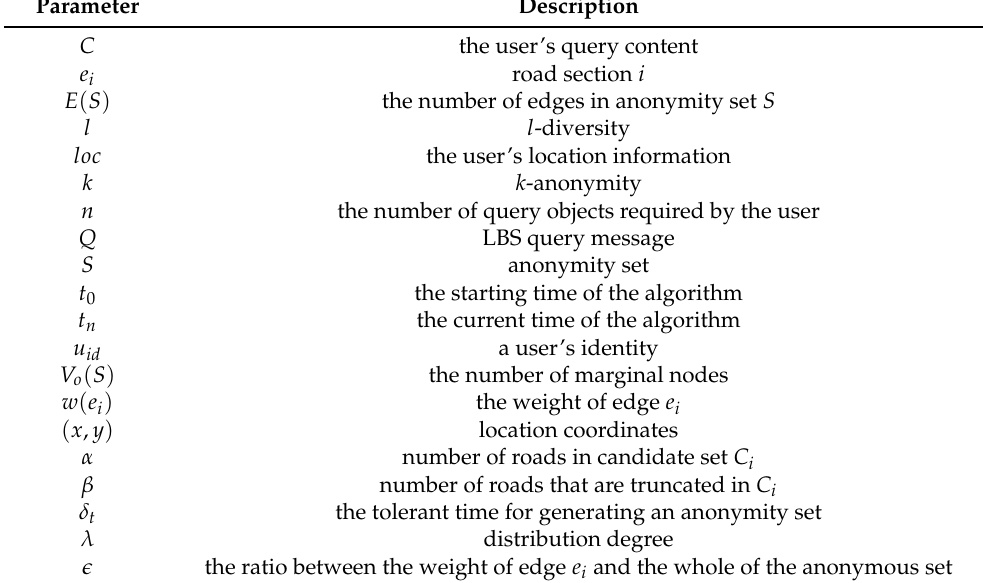
Table 2. Mathematical